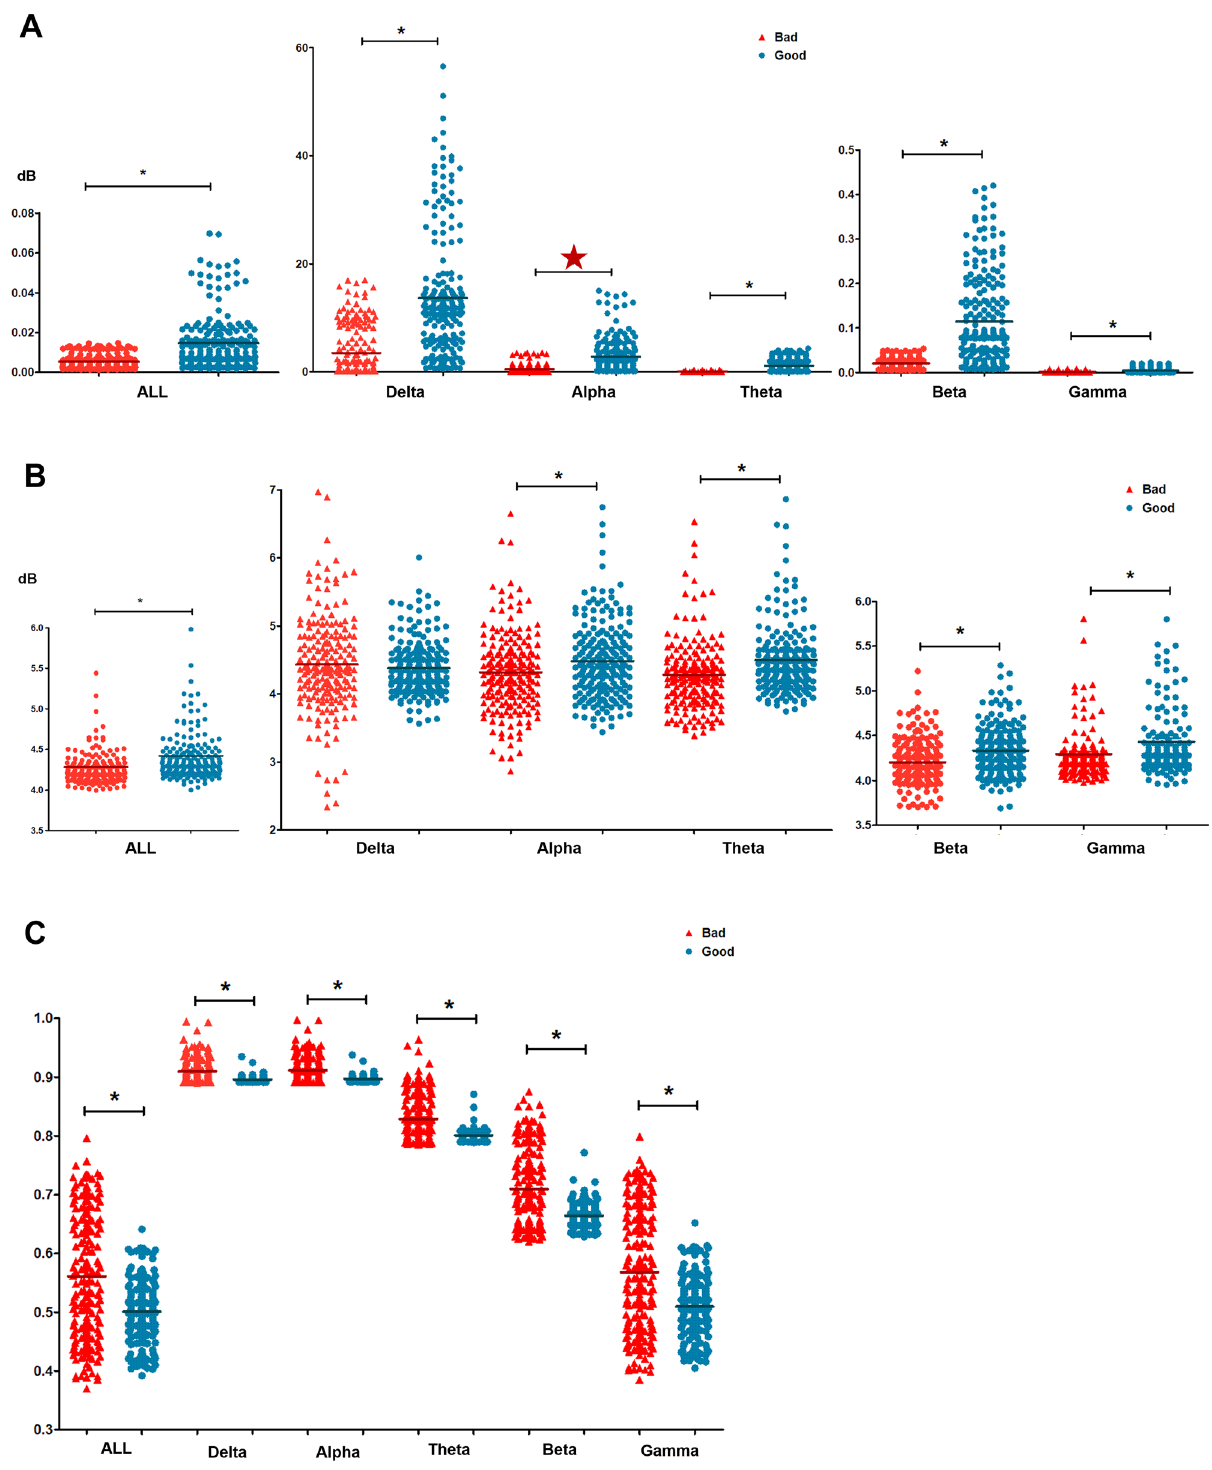
Figure 2. Scattered dots of ( A ) PSD, ( B ) ERSP, and ( C ) SEs of all and each frequency. Small star, p < 0.05; Large start, age-adjusted p < 0.05 by linear mixed